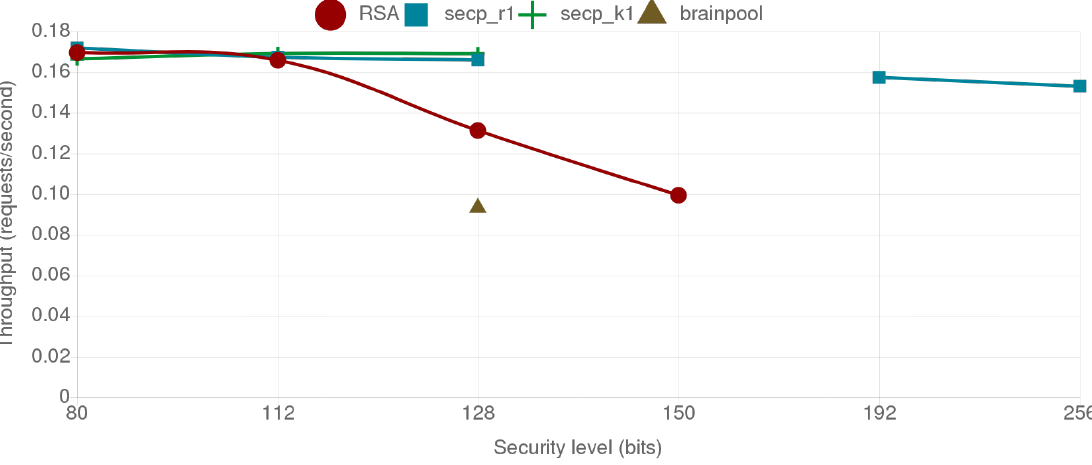
Figure 9. Mist end-device server and mist end-device client combined energy consumption for the different tested alternatives.